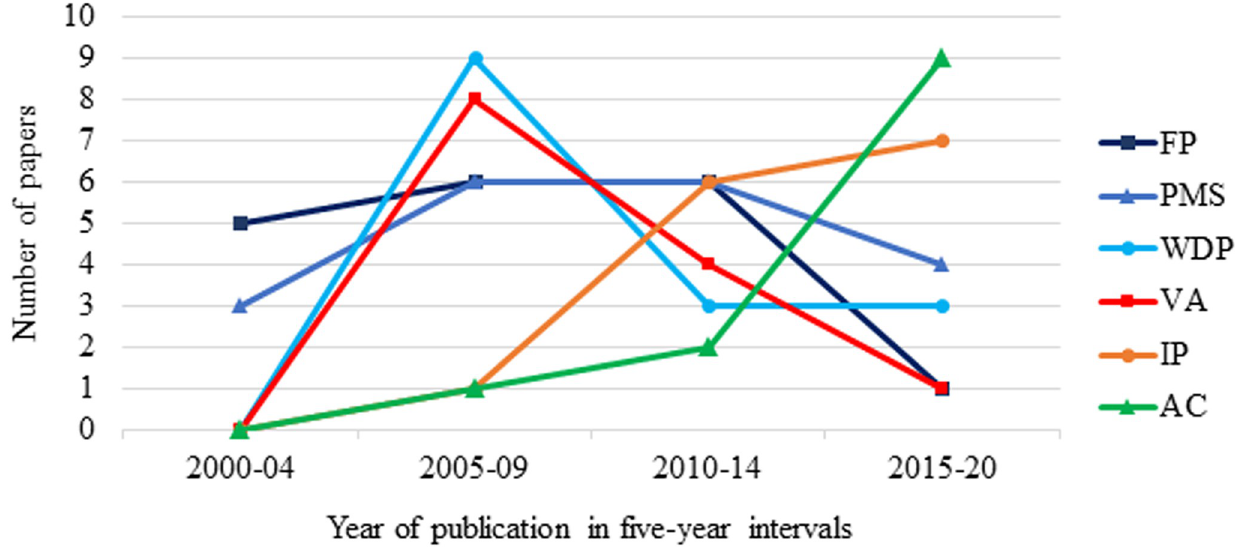
Fig 4. Technology trends in bovine gait analysis plotted in 5-year bins from 2000–2020. Force platforms (FP), pressure mapping system (PMS), weight distribution platforms (WDP), video analysis (VA), image processing (IP), and accelerometer (AC).